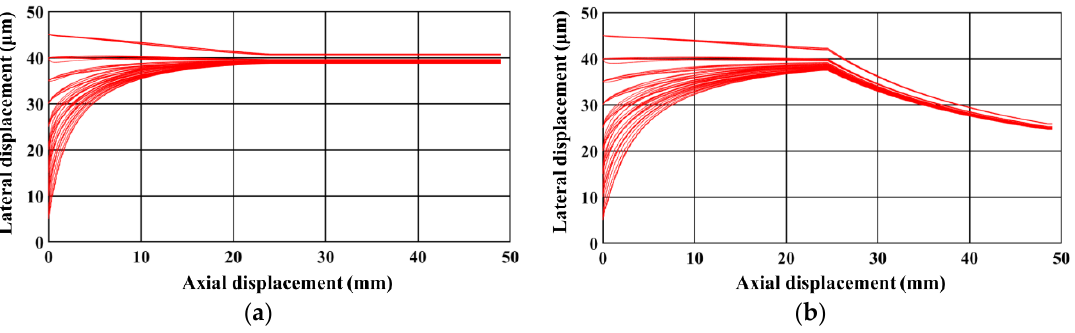
Figure 5. Top view of the trajectory of the ( a ) 2-μm microparticles and ( b ) 2.25-μm microparticles ( d f = 60 μm, l f = 120 μm, d s = 60 μm, l s = 120 μm, Q m = 200 μl/h, w f = 6 μm, w s = 6 μm, n f = 200, n s = 200, V 1 = 3 V pp , V 2 = 15 V pp , V 3 = 15 V pp V 4 = 3 V pp , H ch = 50 μm, W ch = 50 μm, 0 < W o,2.25 < 30 μm, 30 μm < W o,2 < 50 μm, N 1 = N 2 = 10 MHz, N 3 = N 4 = N cr,2 = 473 kHz).